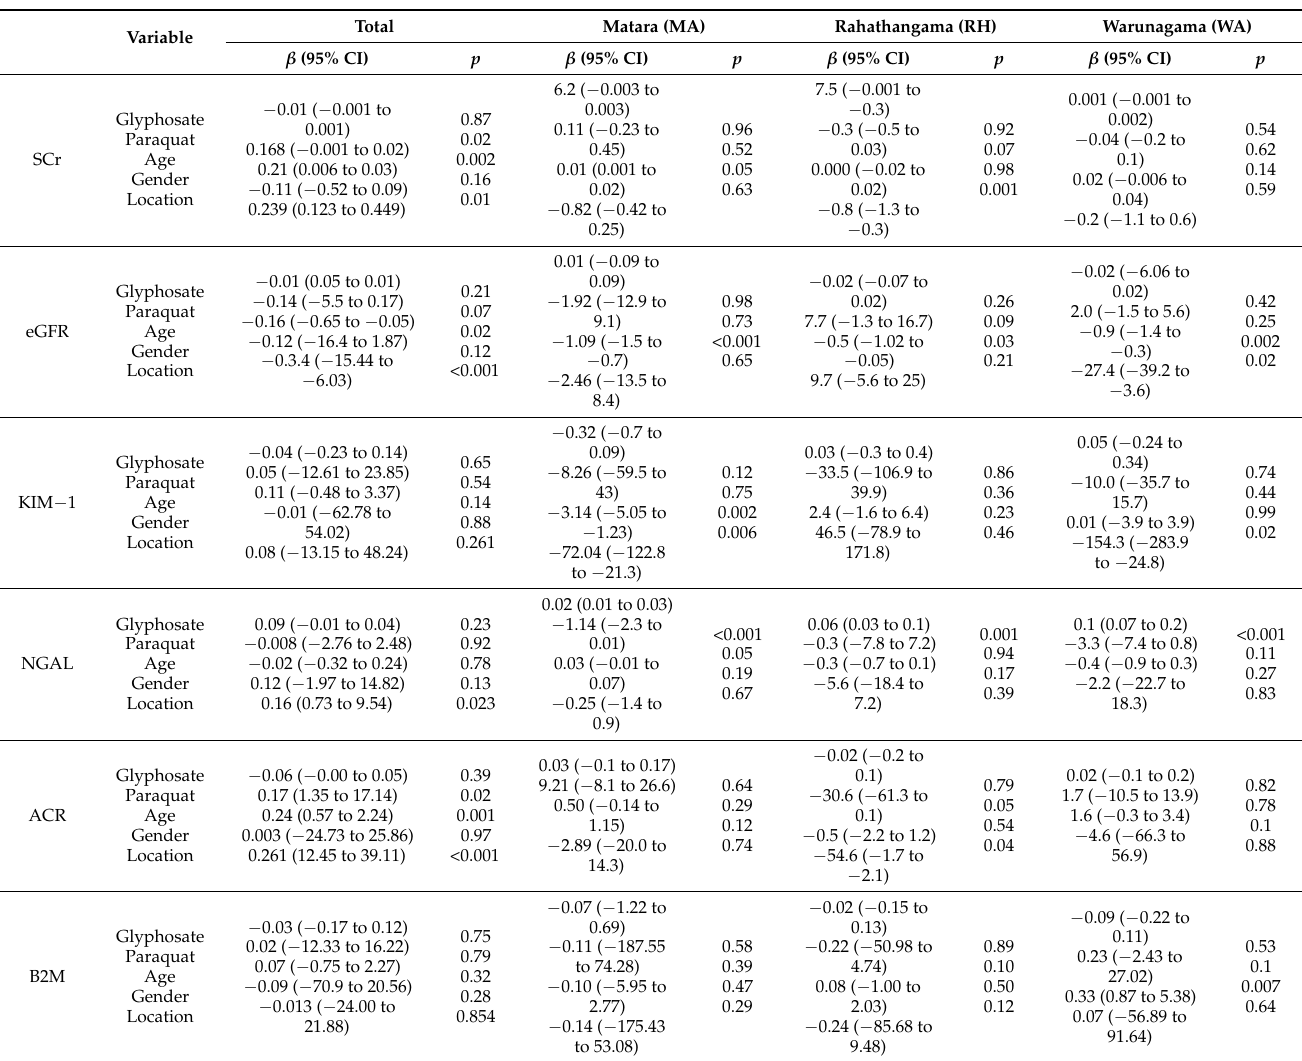
Table 5. Multiple linear regression analysis for the association of glyphosate, paraquat, age and gender and location with renal